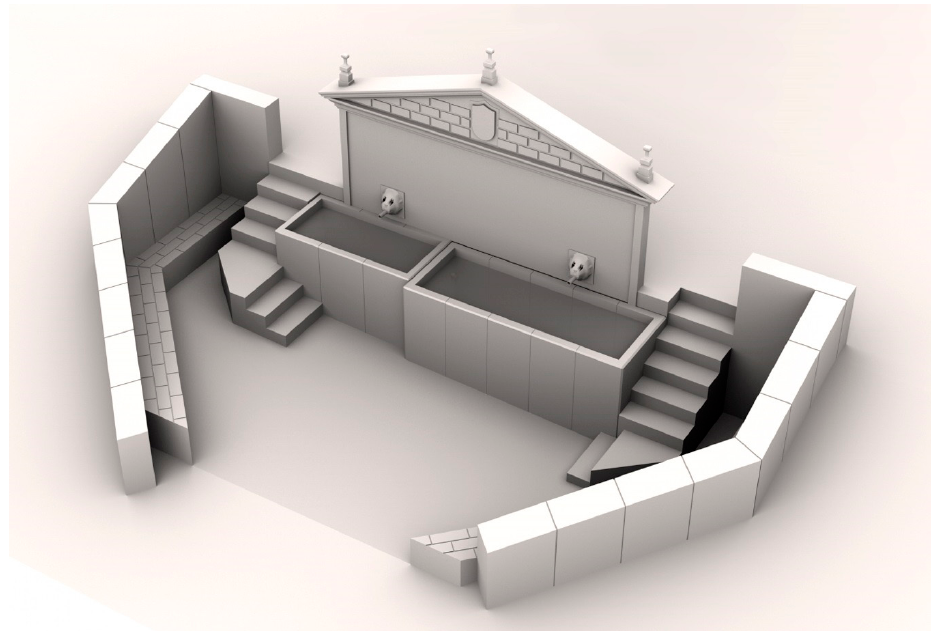
Figure 7. Bird’s eye view of the virtual reconstruction of the Porta Miñá Fountain in Lugo. The image was provided by the authors.